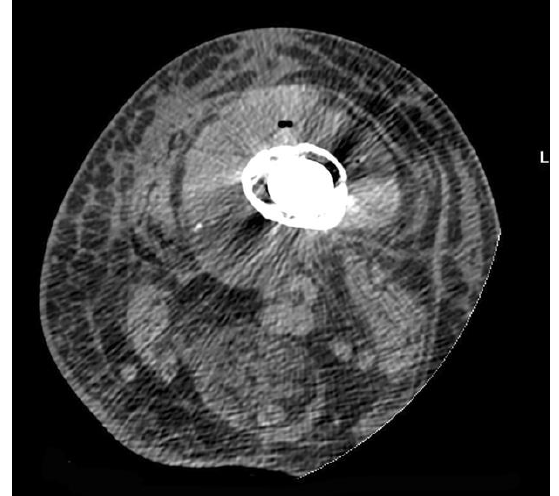
Figure 1. Computed tomography (CT) features: axial scan showing a fluid collection with increasd density surrounding infected bone with a prosthetic implant. Note the swelling and hyperdensity of soft tissues due to edema.